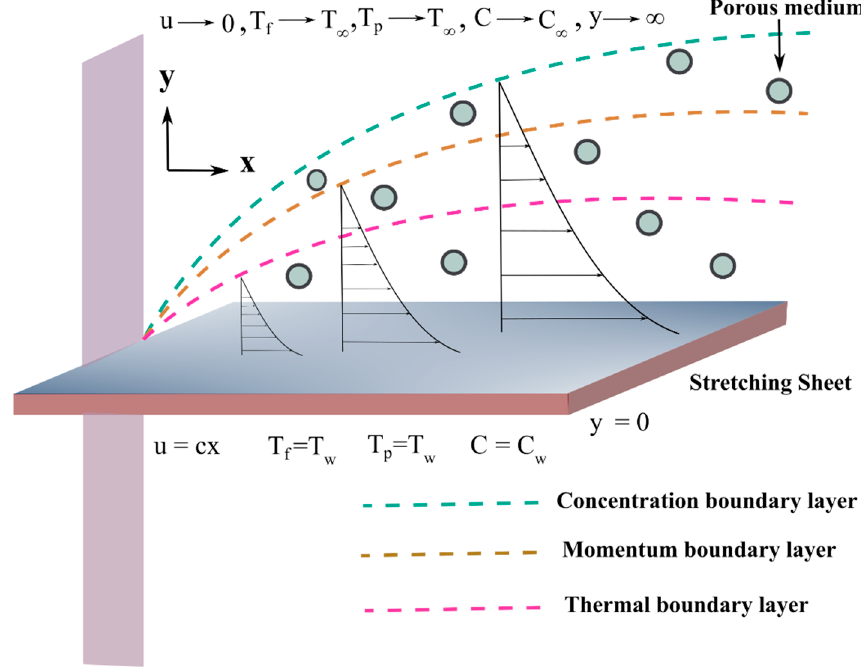
Figure 1. Flow geometry.